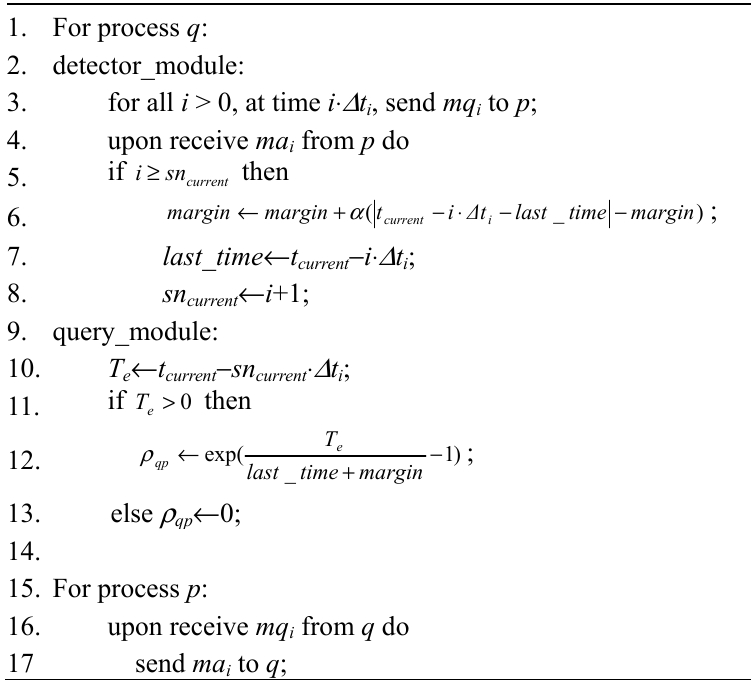
Figure 3. LA-FD failure